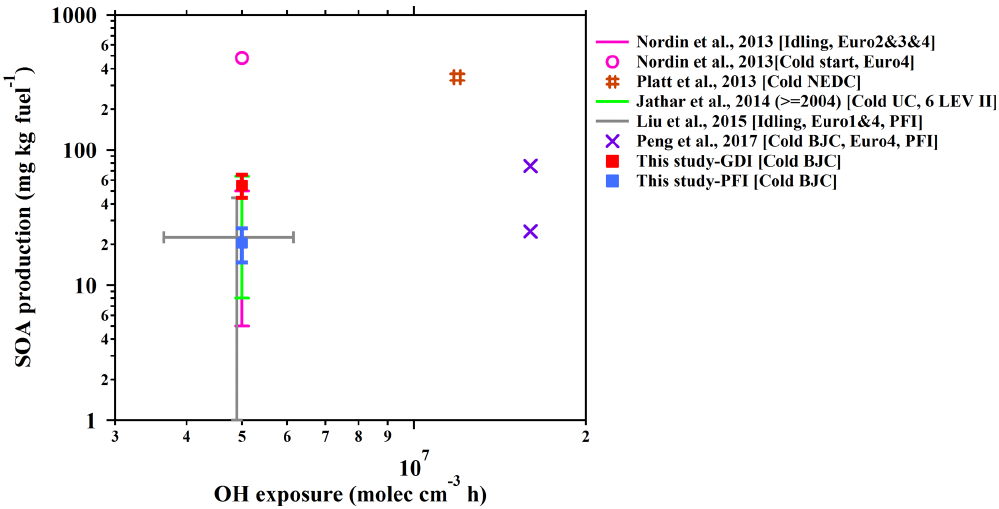
Figure 5. Fuel-based SOA production from gasoline vehicle exhaust as a function of OH exposure in the chamber simulations. The SOA production data are from published studies of chamber simulations of gasoline vehicle exhaust. From the study of Jathar et al. (2014), the SOA production of vehicles manufactured in 2004 or later (LEV II) is selected, which is a model year that is more close to those of the vehicles in this study. The error bars of previous results indicate the range of OH exposure ( x axis) and SOA production ( y axis) in their simulations. The driving cycles and vehicle information are also noted in the legend of each study.